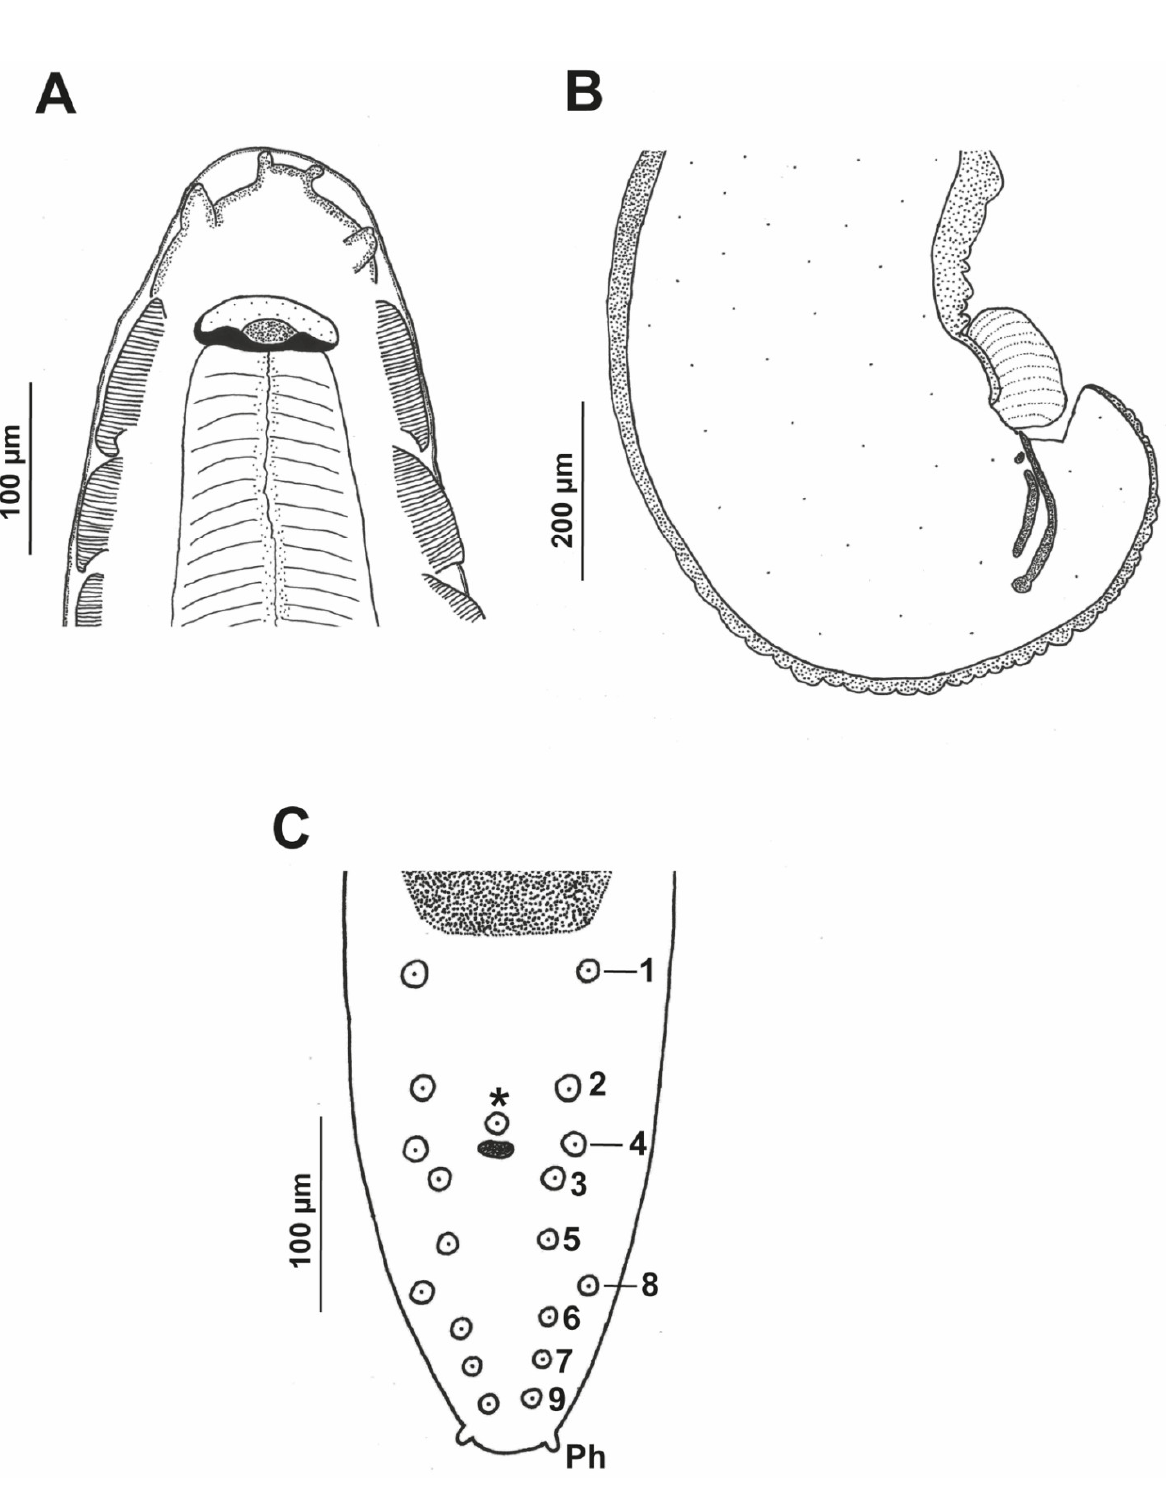
Figure 2. Pterygodermatites ( Pterygodermatites ) plagiostoma male. ( A ) Cephalic extremity, dorsal view. ( B ) Caudal extremity, lateral view. ( C ) Cloacal papillae. (*) Unpaired precloacal papilla; (Ph) phas- mids.